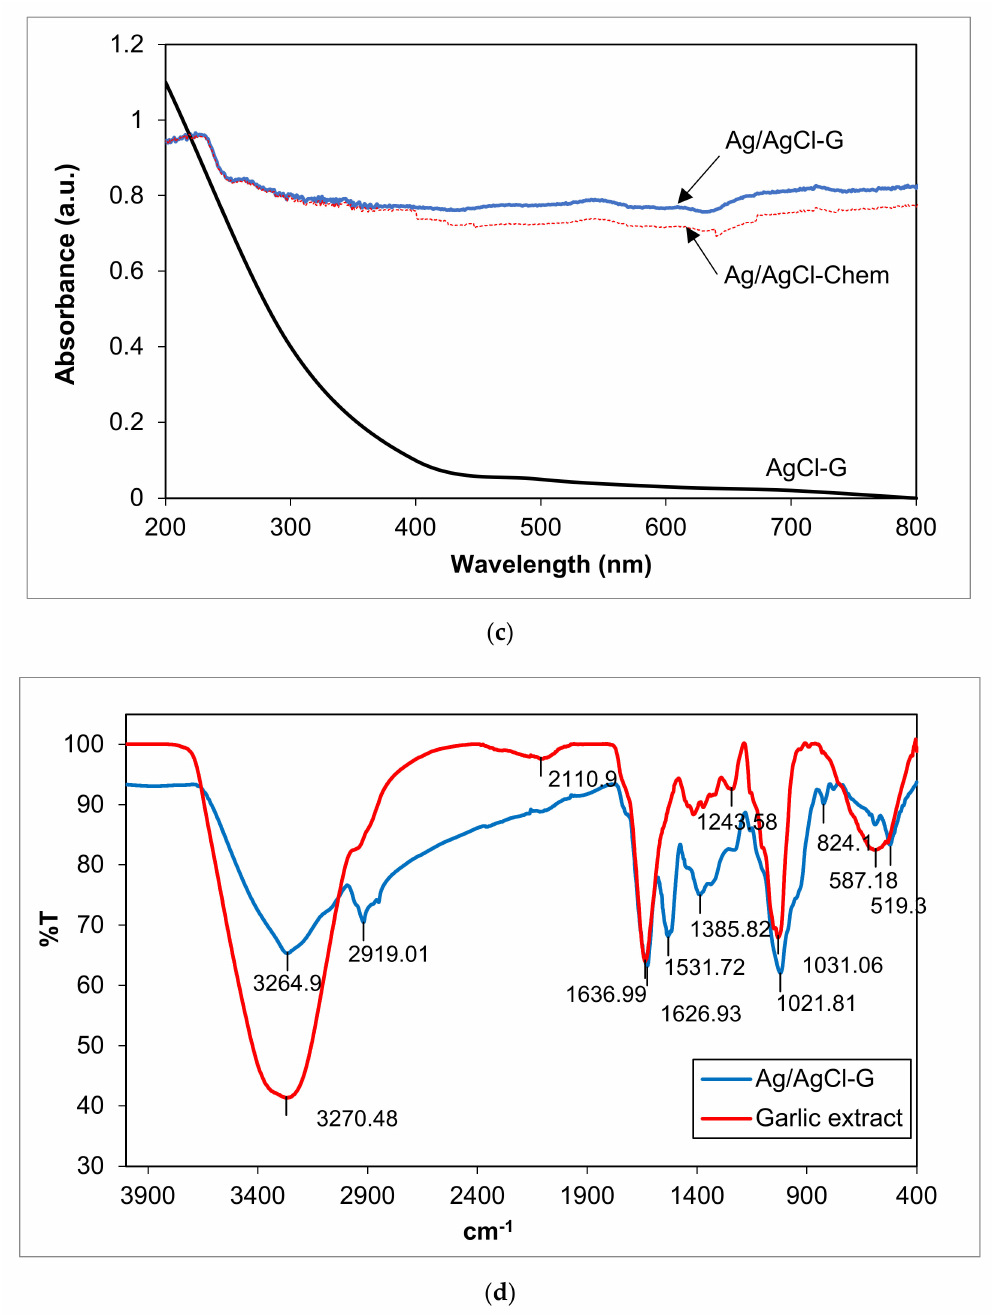
Figure 1. The XRD patterns of Ag/AgCl-G nanoparticles ( a ); zeta potential of Ag/AgCl-G ( b ); absorption spectra of Ag/AgCl-G, Ag/AgCl-Chem, and AgCl-G nanoparticles ( c ); and FTIR spectra of Ag/AgCl-G and garlic extract ( d